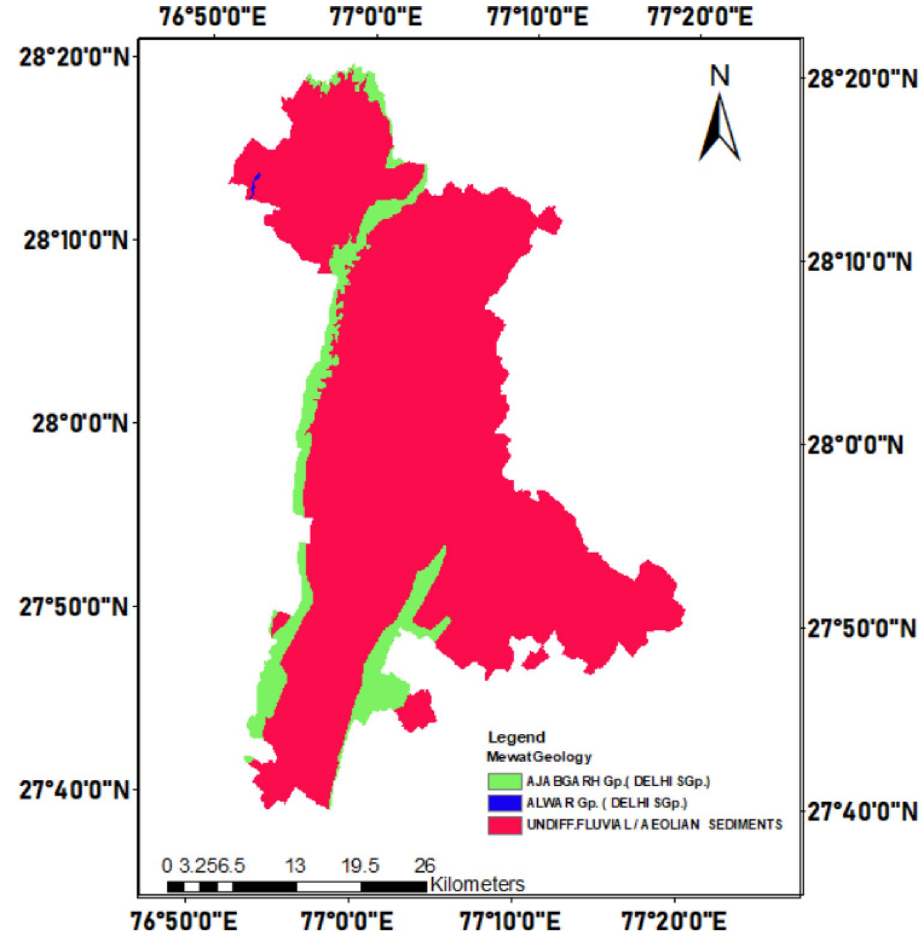
Fig. 6 Geology map of study